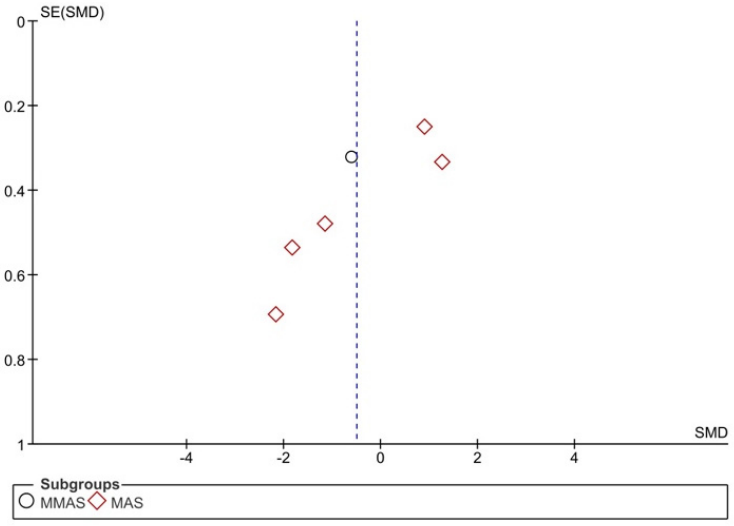
Figure 6. Funnel plot panel of the comparison of the difference between the subgroups in MAS/MMAS.